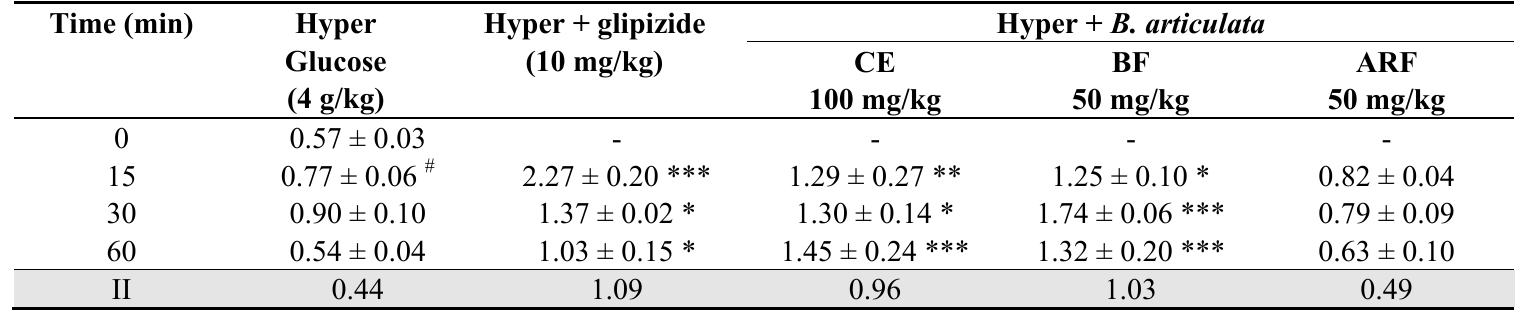
Table 3. Acute effect of crude extract (CE), n -butanol fraction (BF), aqueous residual fraction (ARF) of Baccharis articulata on serum insulin levels (ng/mL) and insulinogenic index (II; ng/mg) a